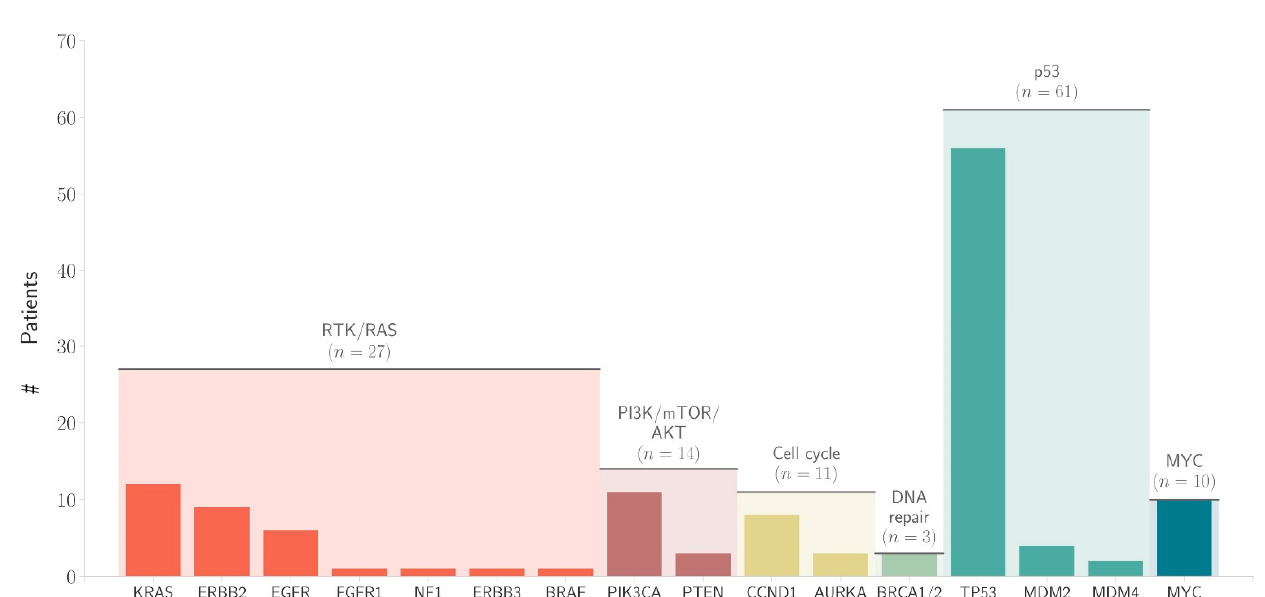
Figure 7. The alterations of the different genes and associated pathways (# indicates number of patients).